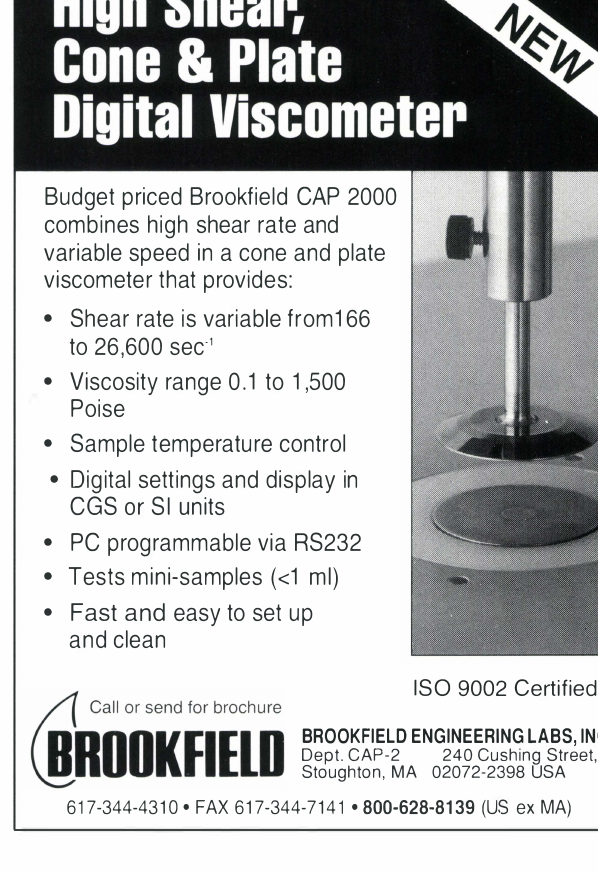
Fig. 3: Limiting energy density for a 000-/ubricant compared with the breaking energy density of iron (D = 5.01 s- 1 ; n � 0.02}